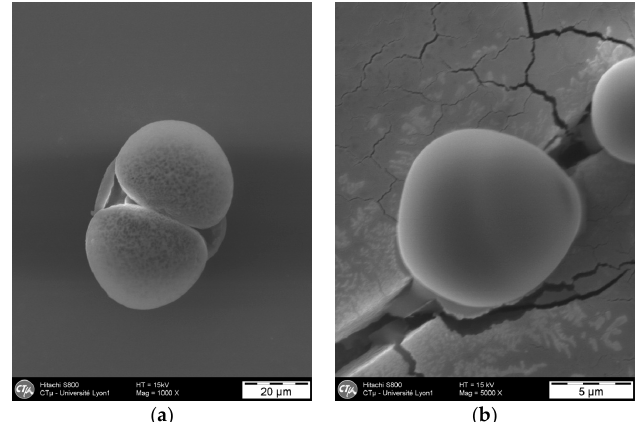
Figure 3. Representative SEM photography of polyamide microparticles obtained (experiment 6). ( a ) 1000× and ( b ) 5000×.